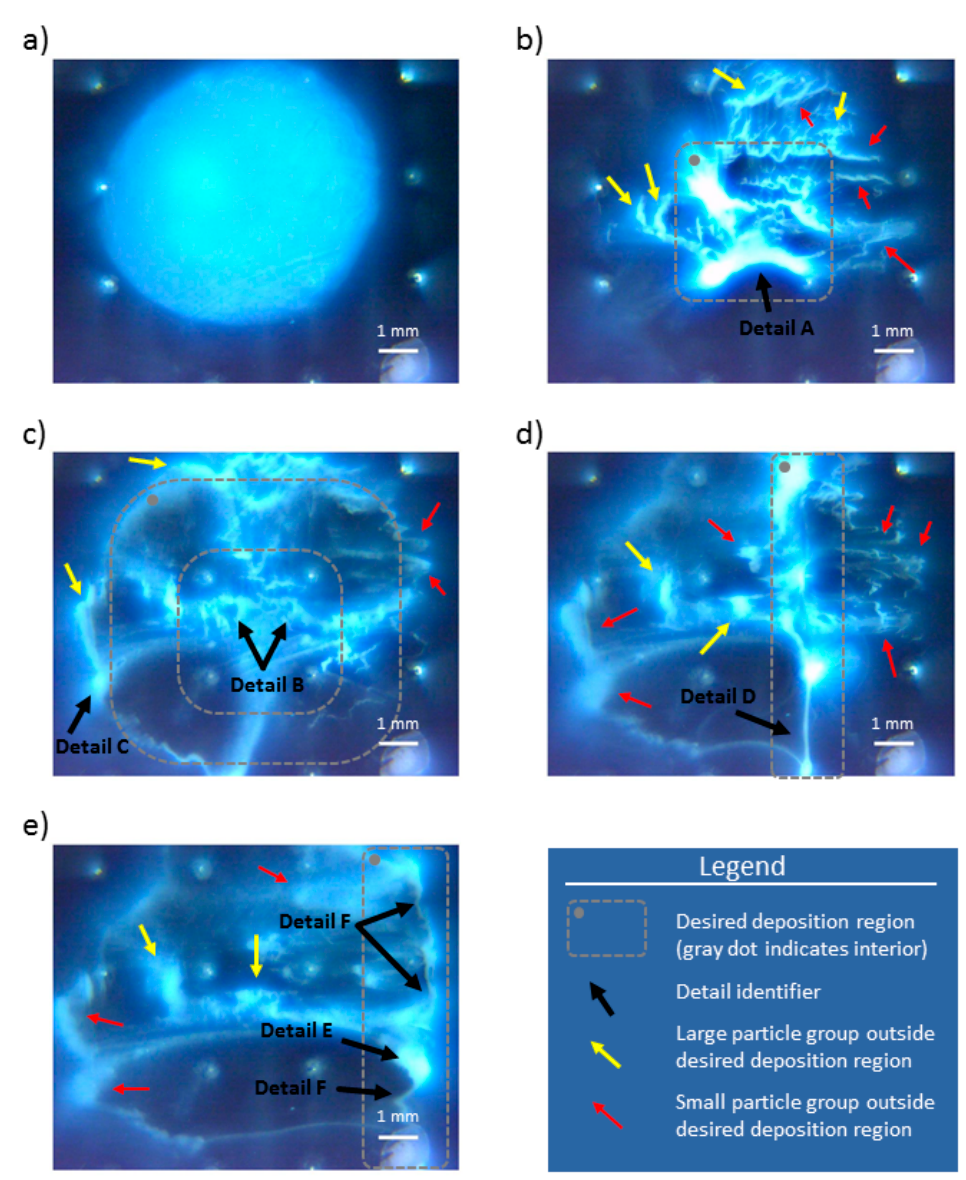
Figure 10. Experimental results of rutile titania (TiO 2 (R)) particle group manipulation. ( a ) Initial particle distribution after settling on the bottom of the mini well; ( b ) particle group distribution after the particles were focused in the middle of the array with the control scheme A; ( c ) particle group spread after defocusing particles with control scheme B; ( d ) particle group arrangement after translation to the 3rd column of the electrode array with control scheme C; ( e ) grouped particles around the 4th column with control scheme D.